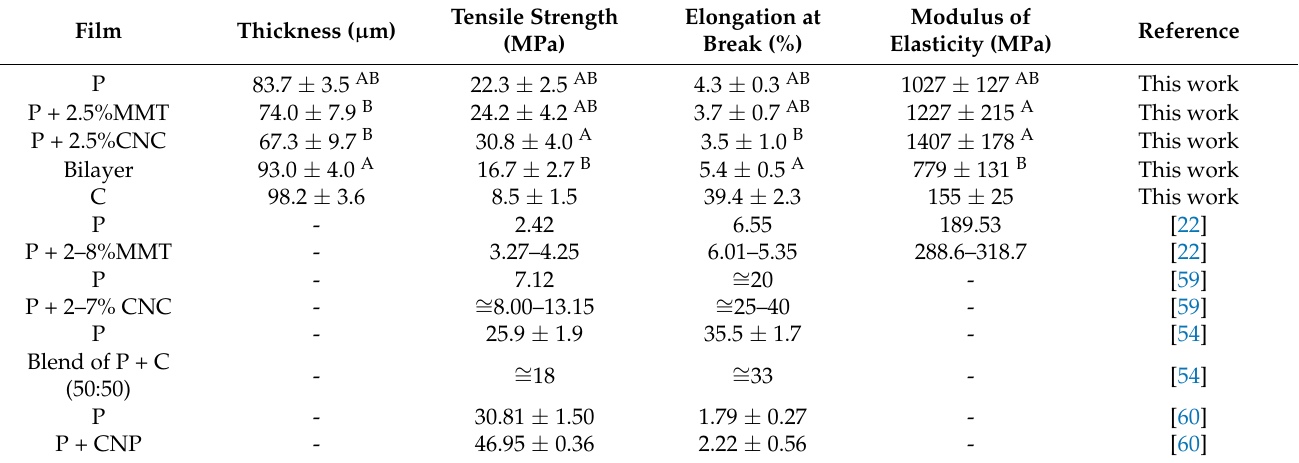
Table 4. Mechanical properties of the films and comparison with data from